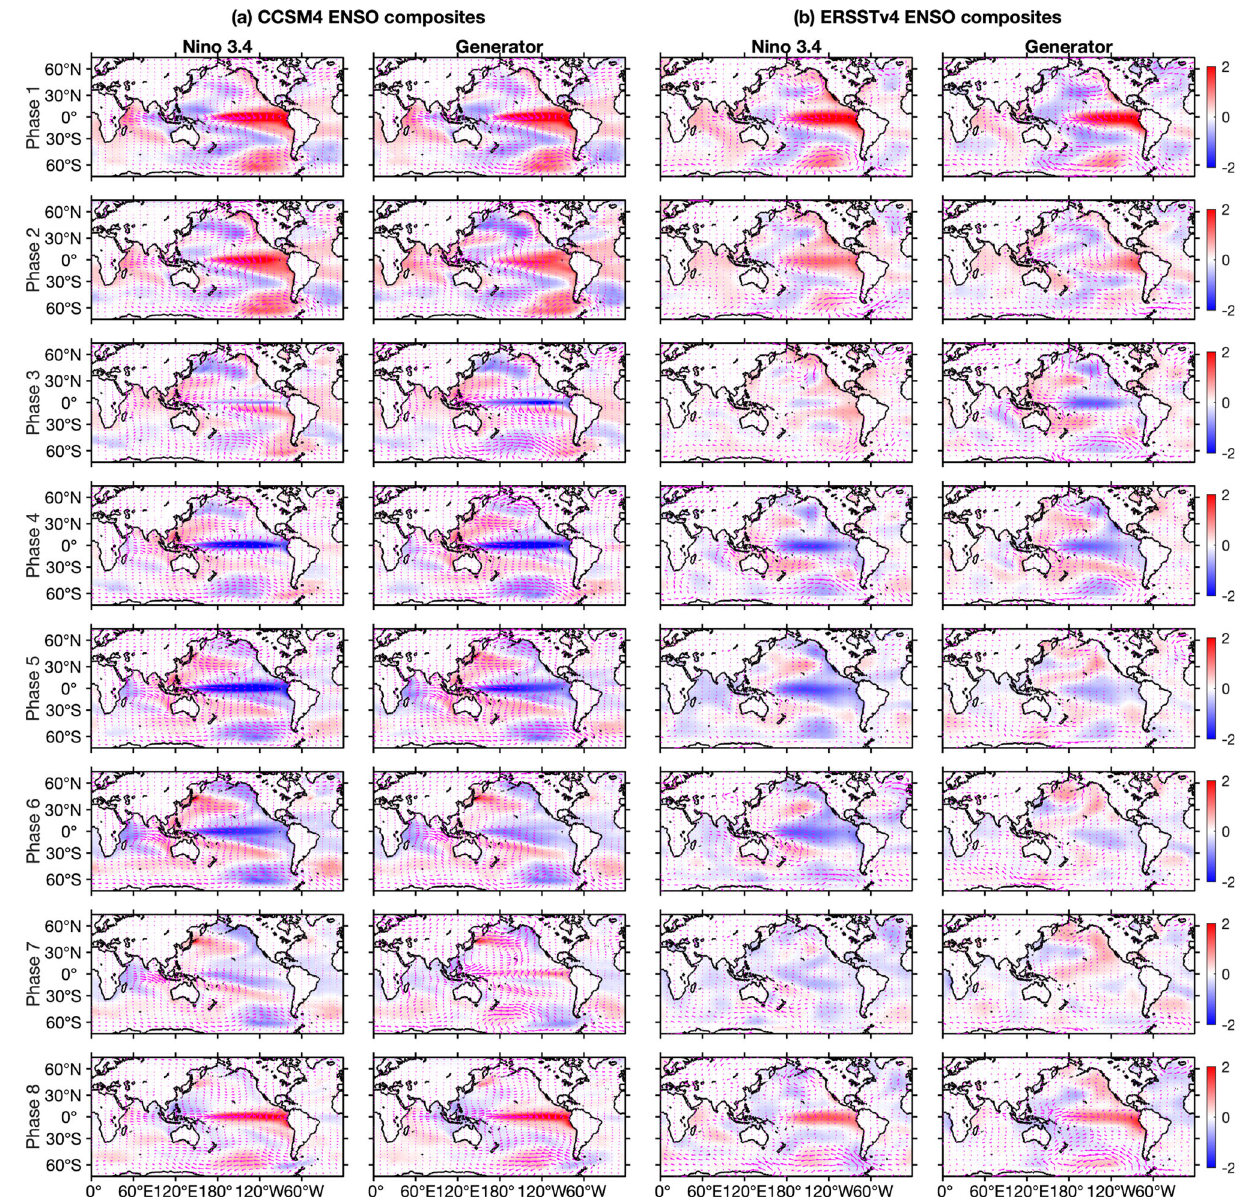
Fig. 7 Phase composites of the ENSO lifecycle. The panels show composites of SST anomalies (K; colors) and surface wind (arrows) anomalies from a CCSM4 and b ERSSTv4 and NCEP/NCAR Reanalysis, based on the Niño 3.4 ( fi rst and third columns from left) and generator phases (second and fourth columns) from Fig. 6. Phases advance row-wise from Phase 1 (top row) to Phase 8 (bottom